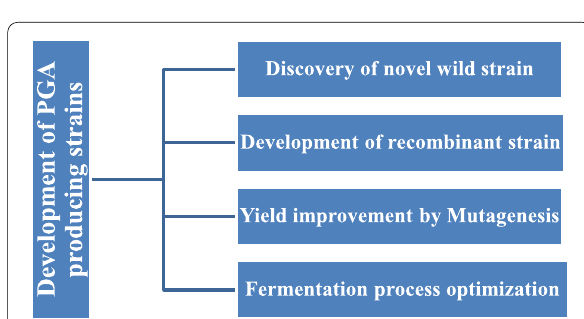
Fig. 2 Strategies adopted by researchers for the production of